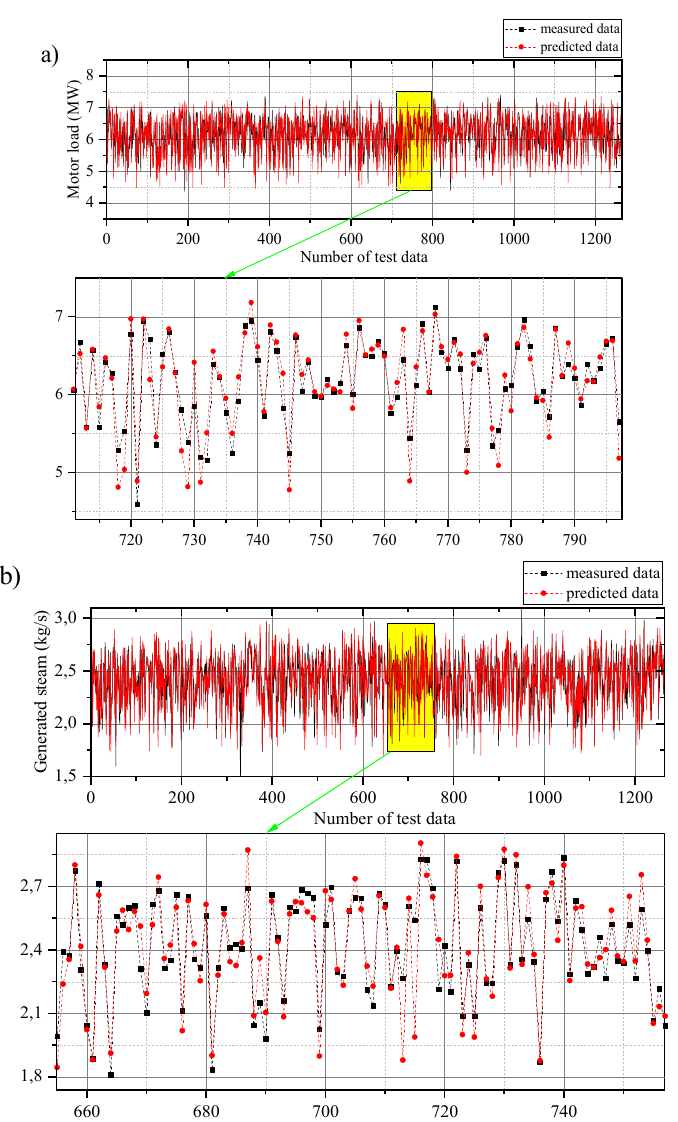
Figure 15. Test samples of PSO to estimate refining motor load ( a ), and refining steam generation ( b ).